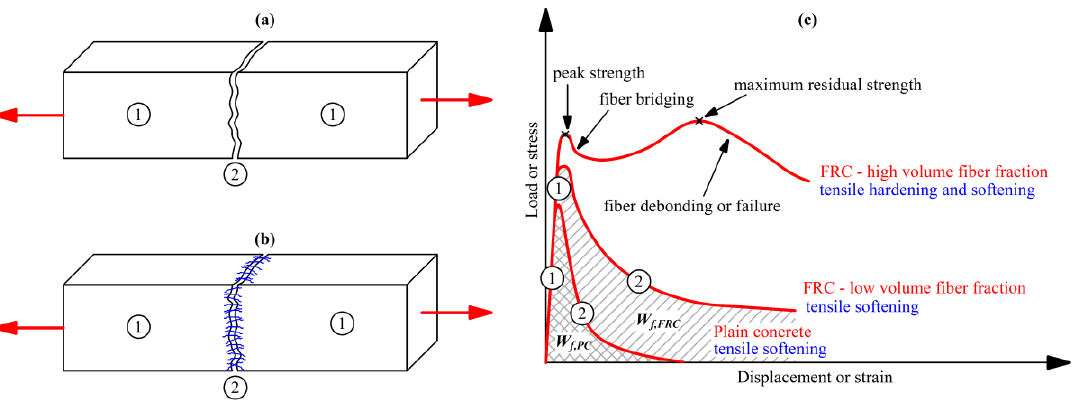
Figure 1. The behavior of plain concrete and fiber-reinforced concrete: ( a ) plain concrete; ( b ) fiber- reinforced concrete; ( c ) load–displacement diagrams. ( b ) fiber-reinforced concrete; ( c ) load–displacement